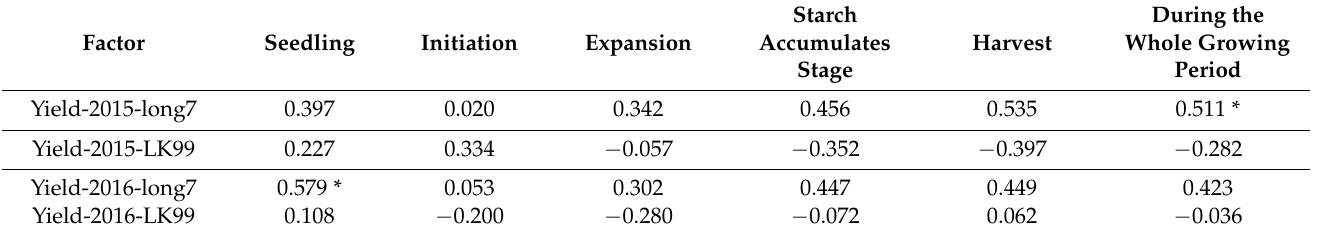
Table 5. Correlation Analysis between Yield and Soil Temperature